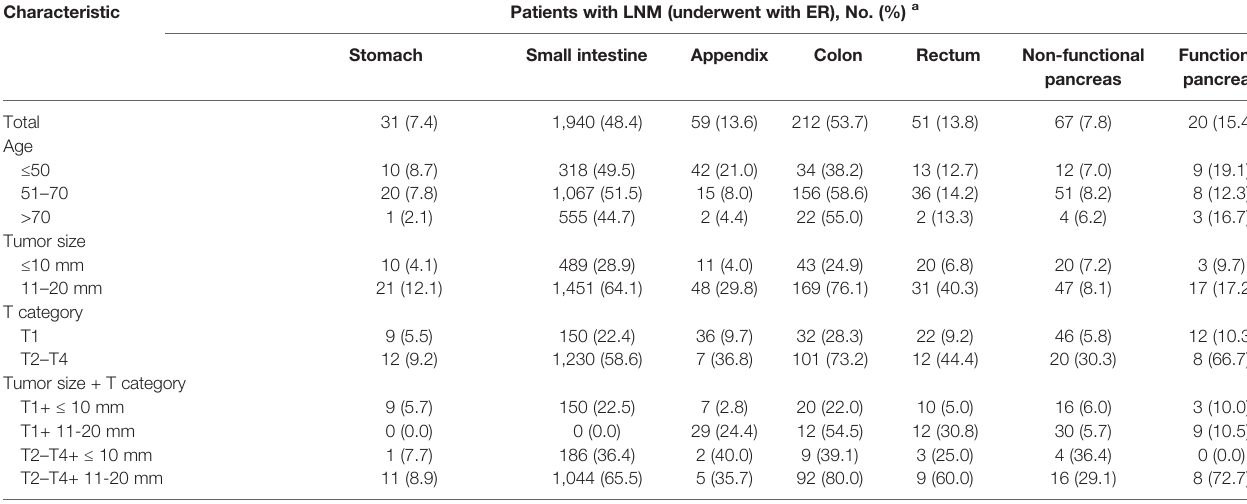
TABLE 2 | Patterns of LNM in small well-differentiated GEP-NETs receiving regional lymphadenectomy. Characteristic Patients with LNM (underwent with ER), No. (%) a